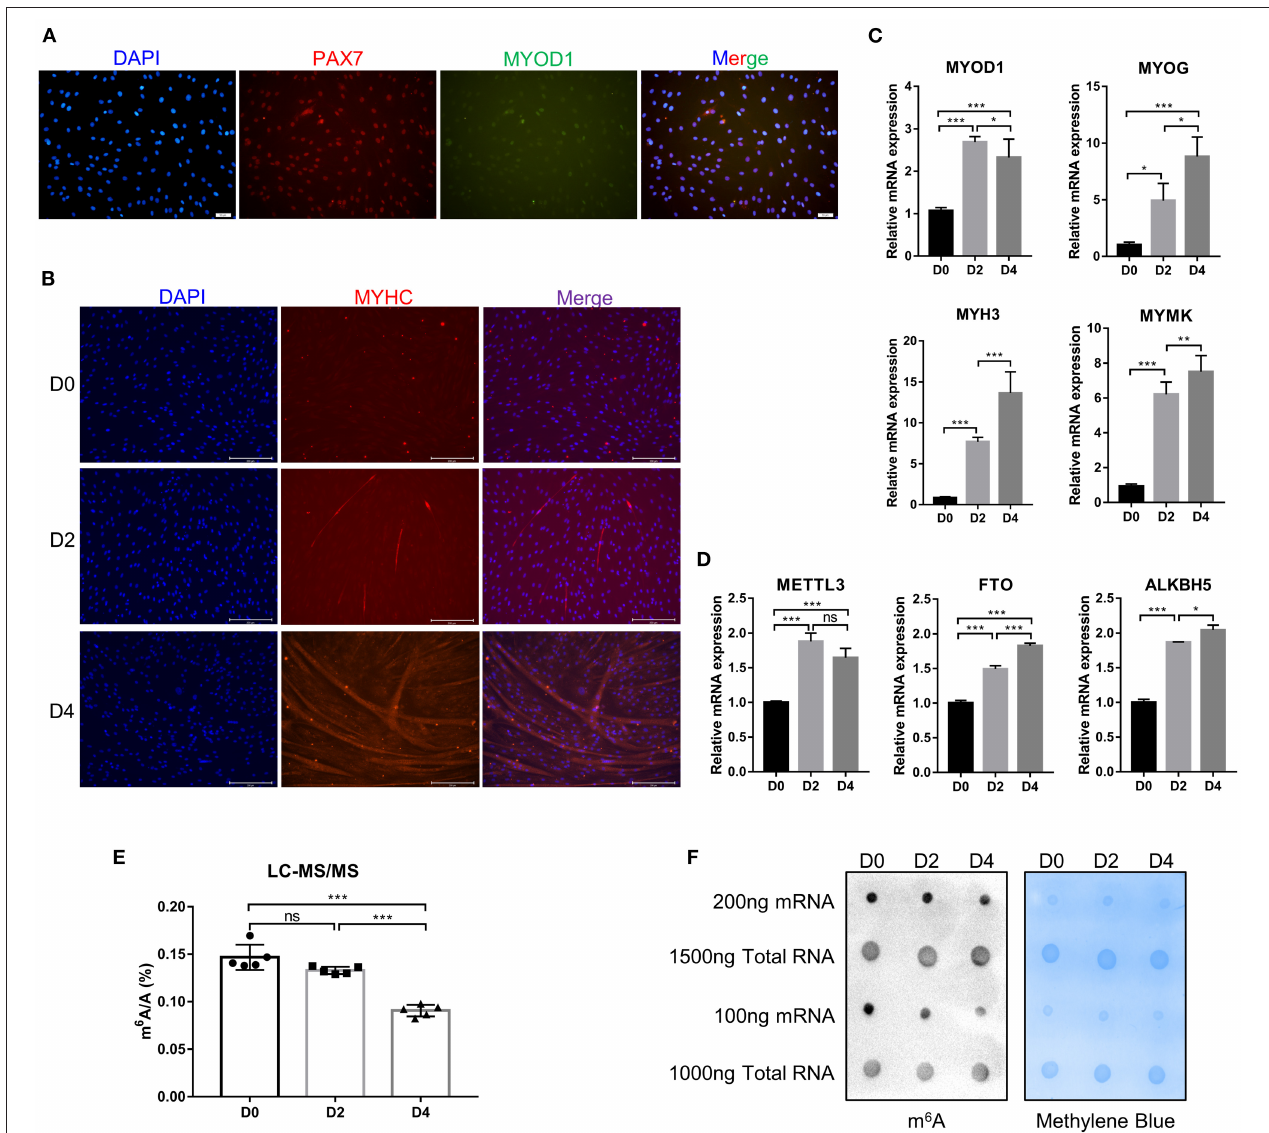
FIGURE 1 | Identification of bovine skeletal myoblasts and detection of m 6 A levels during myogenic differentiation. (A) Identification of myoblasts based on PAX7 and MYOD1 expression in GM (scale bar: 50 µ m, Olympus IX71). (B) Identification of differentiated myotubes based on MYHC expression after culture in DM for 0, 2, and 4 days (scale bar: 200 µ m, Evos-fl-auto2 microscopy imaging system). (C) Relative mRNA expression of myogenic genes ( MYOD1 , MYOG , MYH3 , and MYMK) during bovine skeletal myoblast differentiation. (D) Relative mRNA expression of METTL3 , FTO and ALKBH5 during myoblast differentiation. The results are presented as the means ± SD. (E) LC-MS/MS assay showed the amount of mRNA m 6 A during myoblast differentiation. Data are presented as mean ± SD ( n = 5). (F) Dot blotting was used to detect the m 6 A modification of mRNA and total RNA at D0, D2, and D4 during bovine skeletal myoblasts differentiation. Methylene blue (MB) staining was used as a loading control. (C–E) * p < 0.05, ** p < 0.01, *** p < 0.001, ns, no